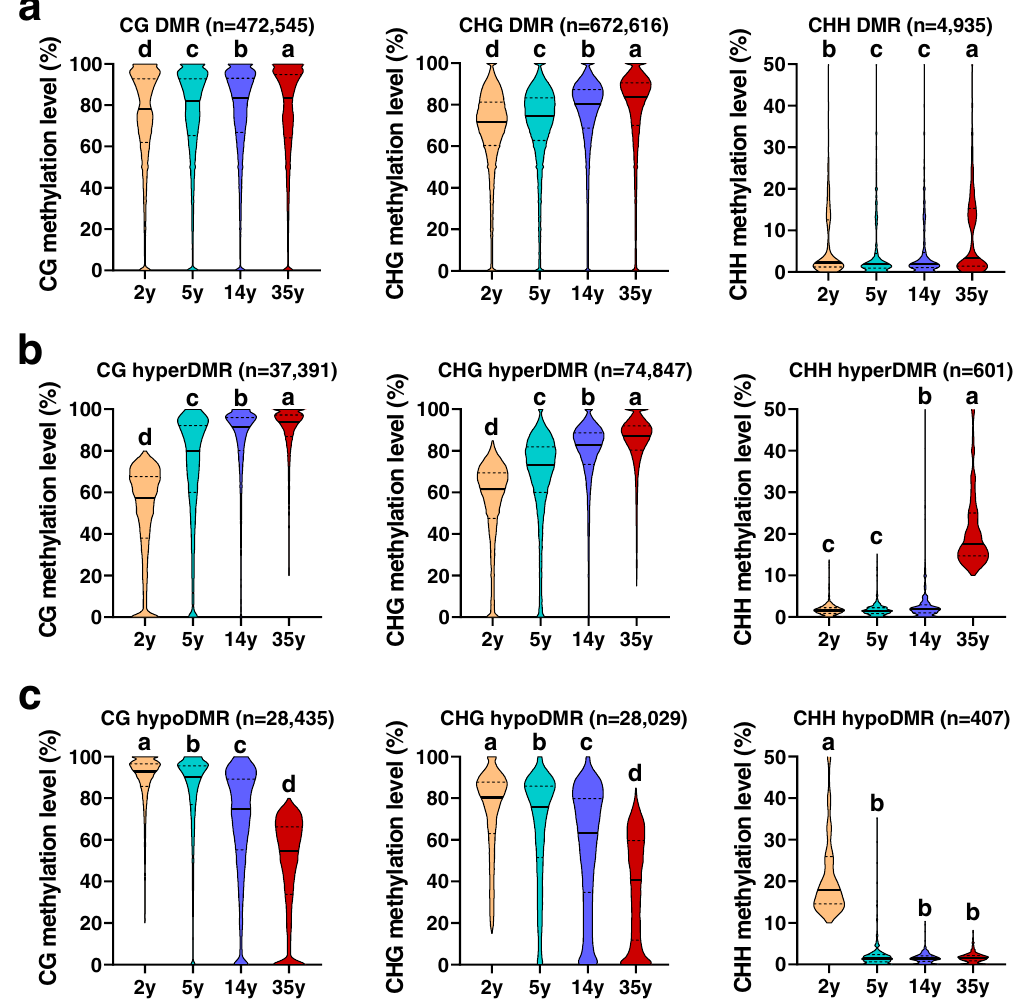
Fig. 4 | Genome-wide dynamic in DNA methylation during age progressed in Chinesepine.a DNAmethylationlevelsofallreservedDMRsbetweensampleswith bigage gaps (35y vs. 2y, 35y vs. 5y, and 14y vs. 2y)at2,5,14, and 35years.These reserved DMRs were those that have excluded DMR parts overlapping with DMRs between two biological replicates within each of the four age groups. b The methylation level changes of reserved overlapped hyper-DMRs in at least two